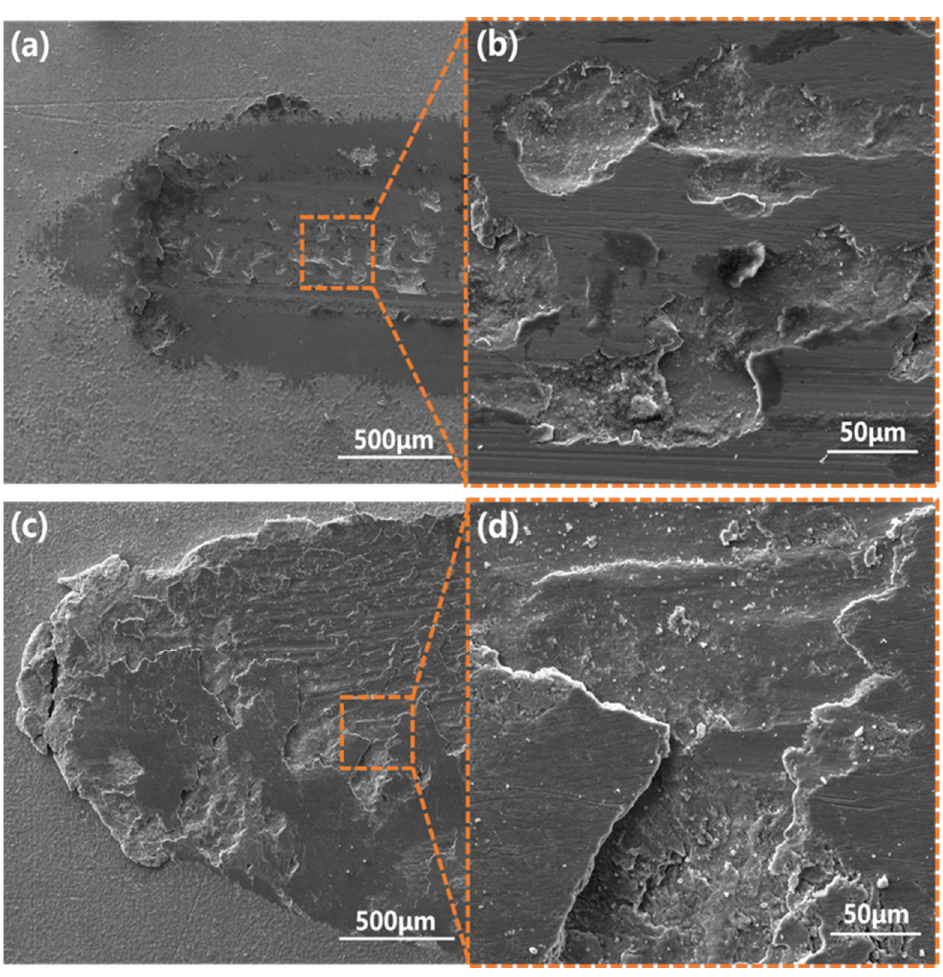
Figure 12. Wear scar morphologies of ( a , b ) chromized T9 steel and ( c , d ) chromized SPCC